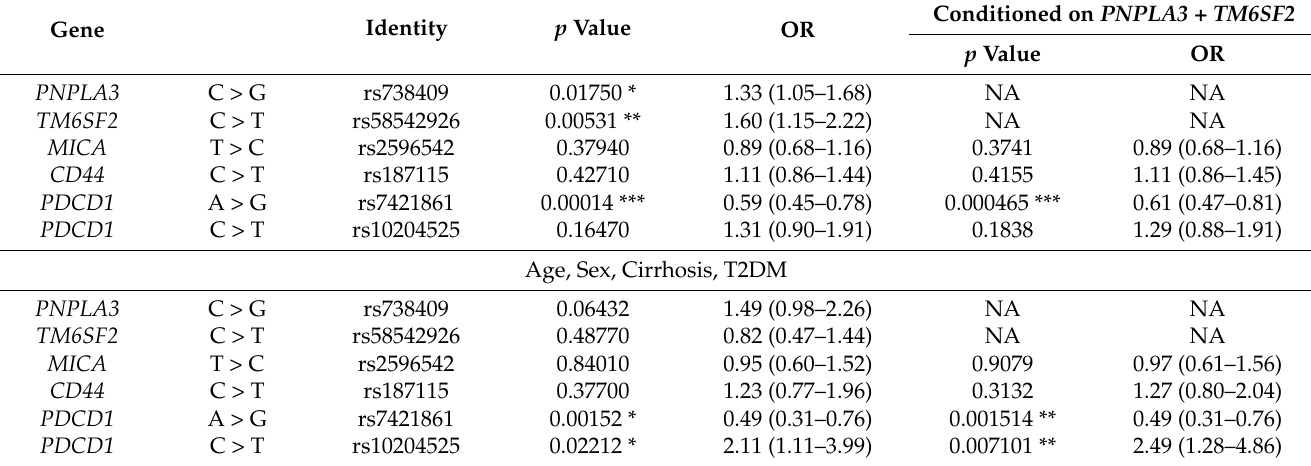
Table 2. Allelic analyses, including multivariate regression and conditioning on the fat-regulatory genes. Gene Identity p Value OR